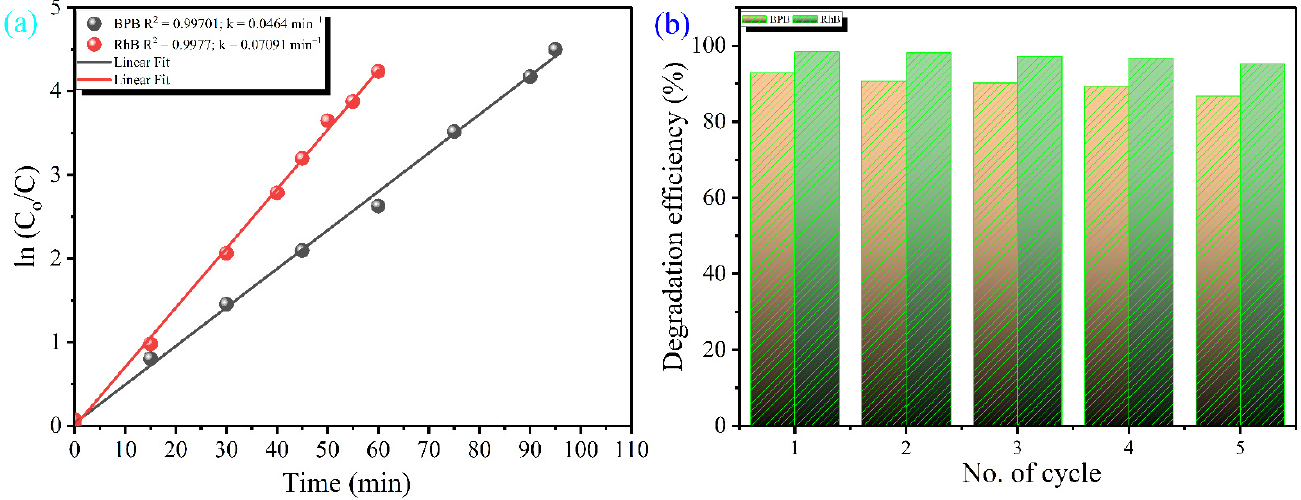
Figure 8. ( a ) Kinetics and ( b ) recyclability plot for the photocatalytic degradation efficiency of BPB and RhB using the ZC3 nanocomposite.